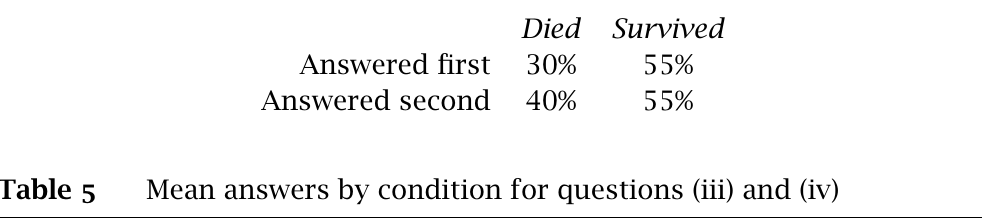
Mean answers by condition for questions (iii) and (iv)